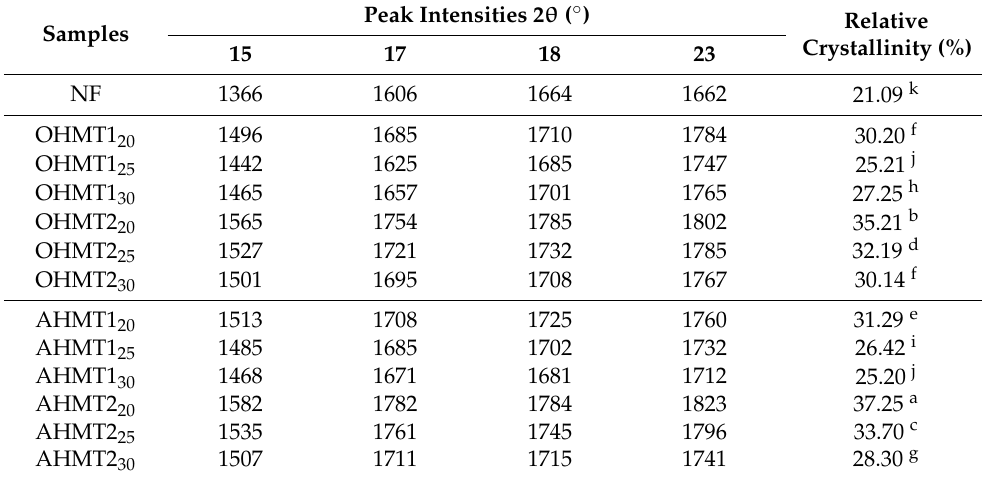
Table 3. The peak intensities and relative crystallinity values of native and HMT purple rice flour samples.